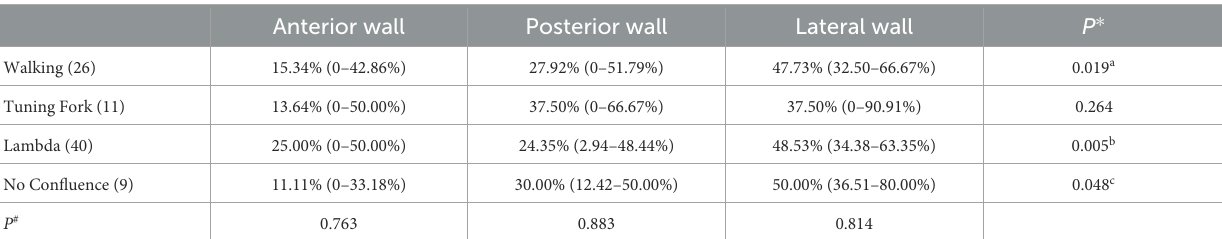
TABLE 4 Vertebrobasilar geometric configuration and BA plaque distribution.